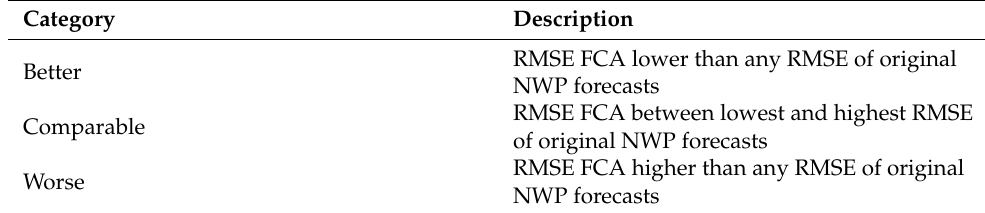
Table 4. Algorithm’s performance categories.